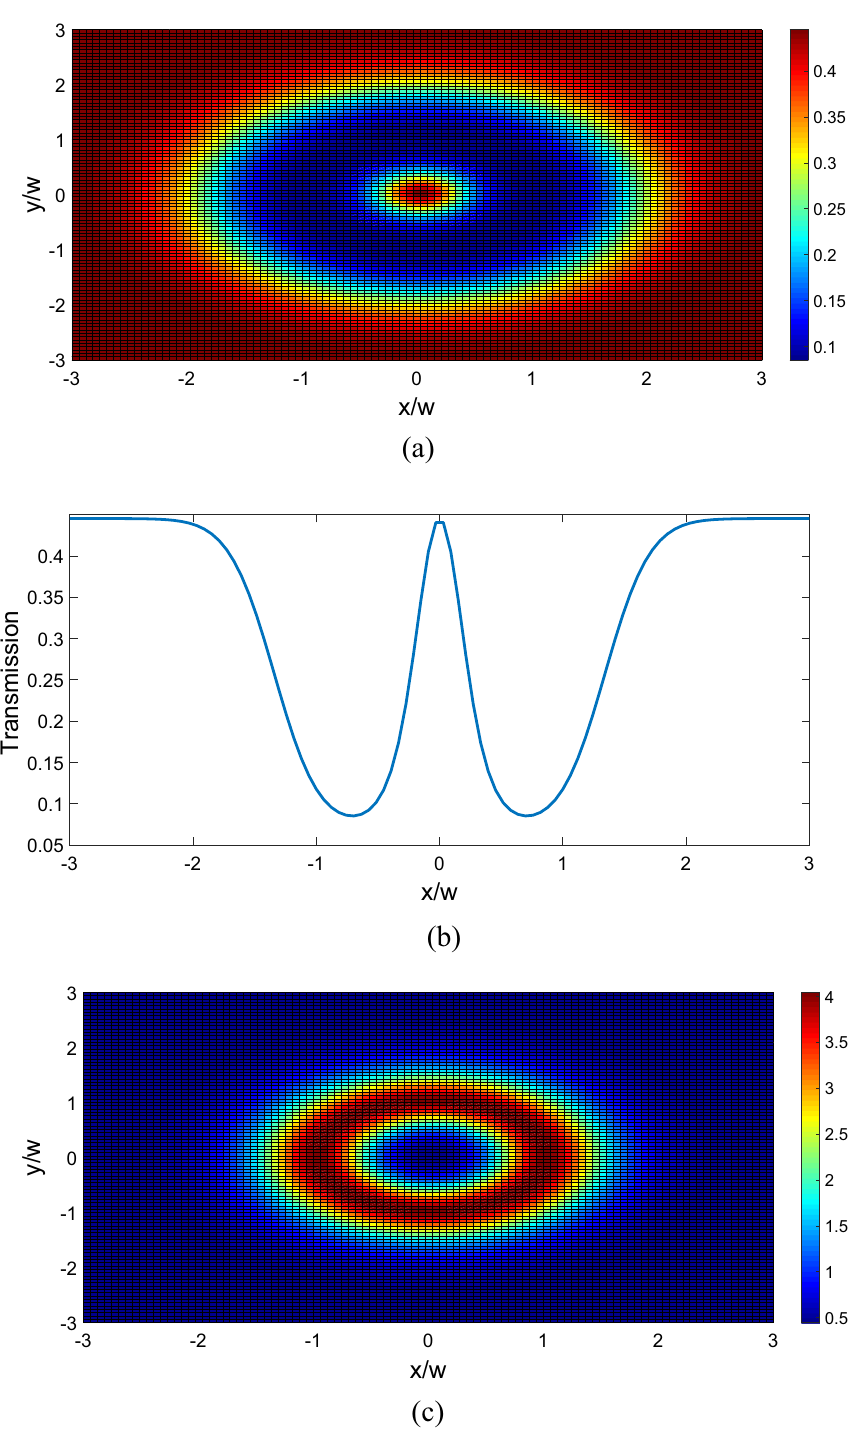
Figure 6. Three dimensional probe field transmission in transverse ( x – y ) plane ( a ), probe field transmission as a function of normalized position x / ω for l = 2 ( b ). Three dimensional probe field transmission in transverse ( x – y ) plane ( c ), probe field transmission as a function of normalized position x / ω for l = − 2 ( d ). Probe field absorption as a function of normalized position x / ω for l = 2 and l = − 2 ( e ). Other selected parameters are �ϕ = 0, � p = 0.2 γ , � d = 0.9 γ , ω c = 1 µ m, � =